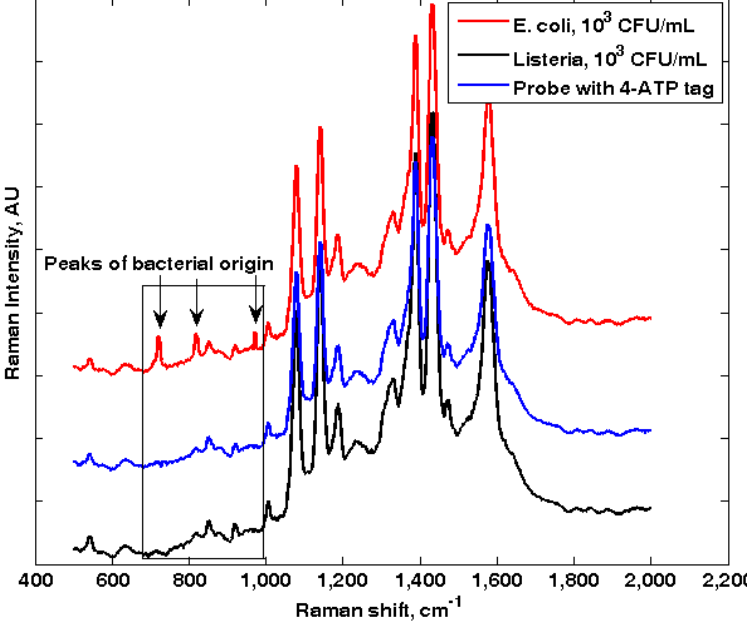
Figure 4. SERS spectra of silver nanoprobes functionalized with anti- E. coli antibodies (blue) incubated with E. coli (red) and Listeria (black). No bacterial-originated peaks can be observed when non-target species is integrated with the